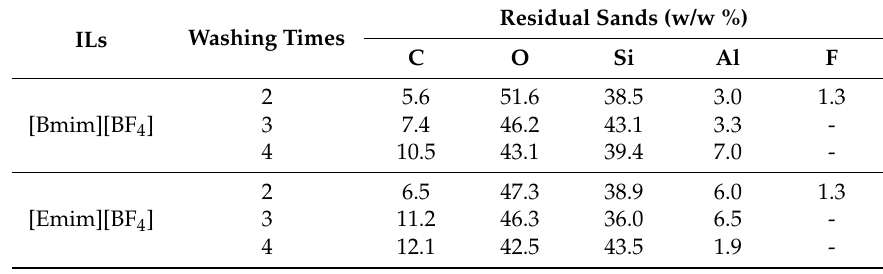
Table 3. Elemental composition in the residual sands with different washing times after ionic liquids